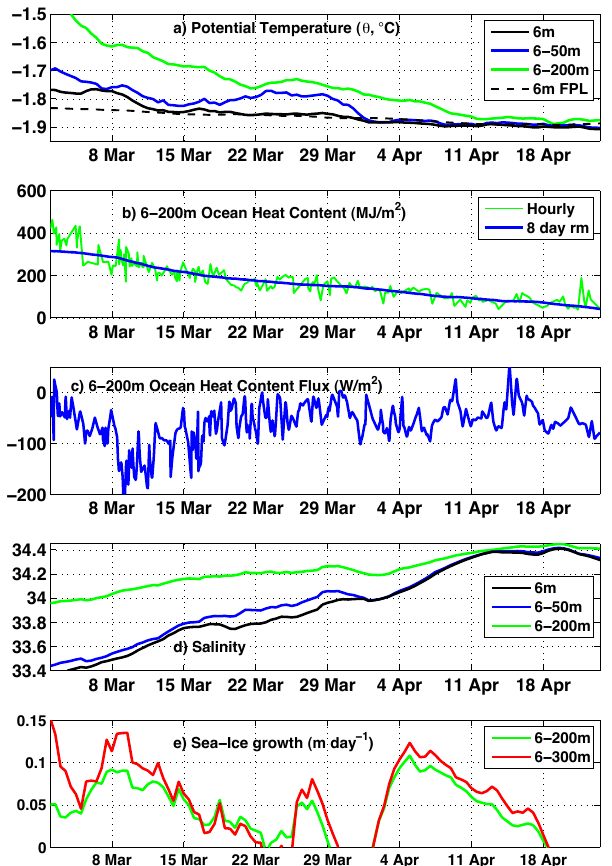
Fig. 10. Time series of ocean properties, linearly interpolated from the seal CTD data onto an hourly grid. From top to bottom, (a) Potential temperature ( ◦ C, 4-day running mean) at the near-surface (6m, black line) and averaged over the 6–50m (blue) and 6–200m (green) depth range. Near-surface freezing points shown as dashed black line; b) Ocean Heat Content in the 6–200m layer (MJm − 2 ) from Eq. (1). Data shown is hourly (green) and the 8-day run- ning mean of the hourly data (blue); c) Ocean Heat Content Flux (Wm − 2 ) from Eq. (2), based on the 8-day running mean data (blue) shown in b); d) as in a), but for salinity and (e) Sea ice growth rates (mday − 1 ) from the salinity budget (Eq. 3). Estimates are for the 6– 200m layer and 6–300m layer (green and red, respectively).